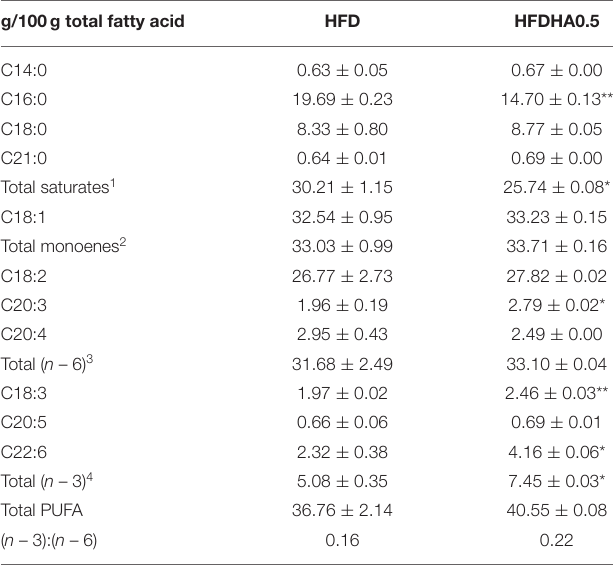
Frontiers in Nutrition |